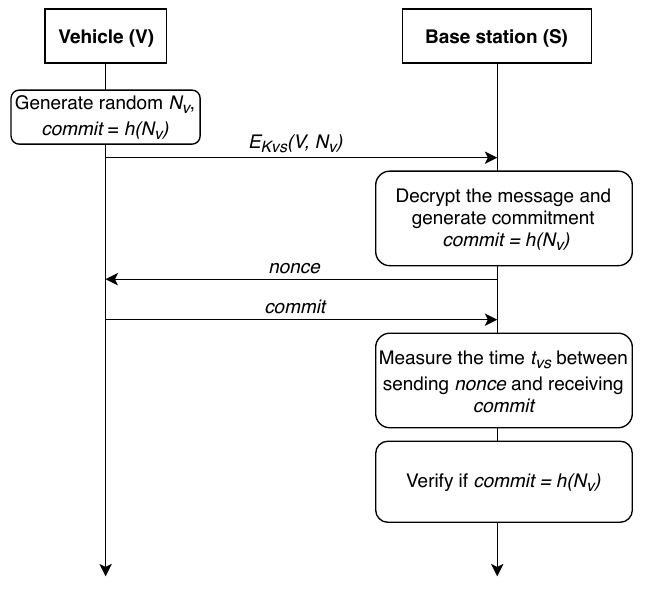
Figure 5. Potential improvement of distance-bounding